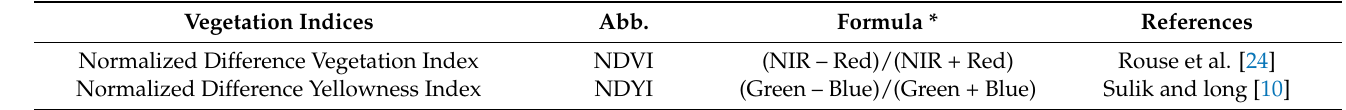
Table 2. Spectral vegetation indices derived from Red–Green–Blue images in this study. Vegetation